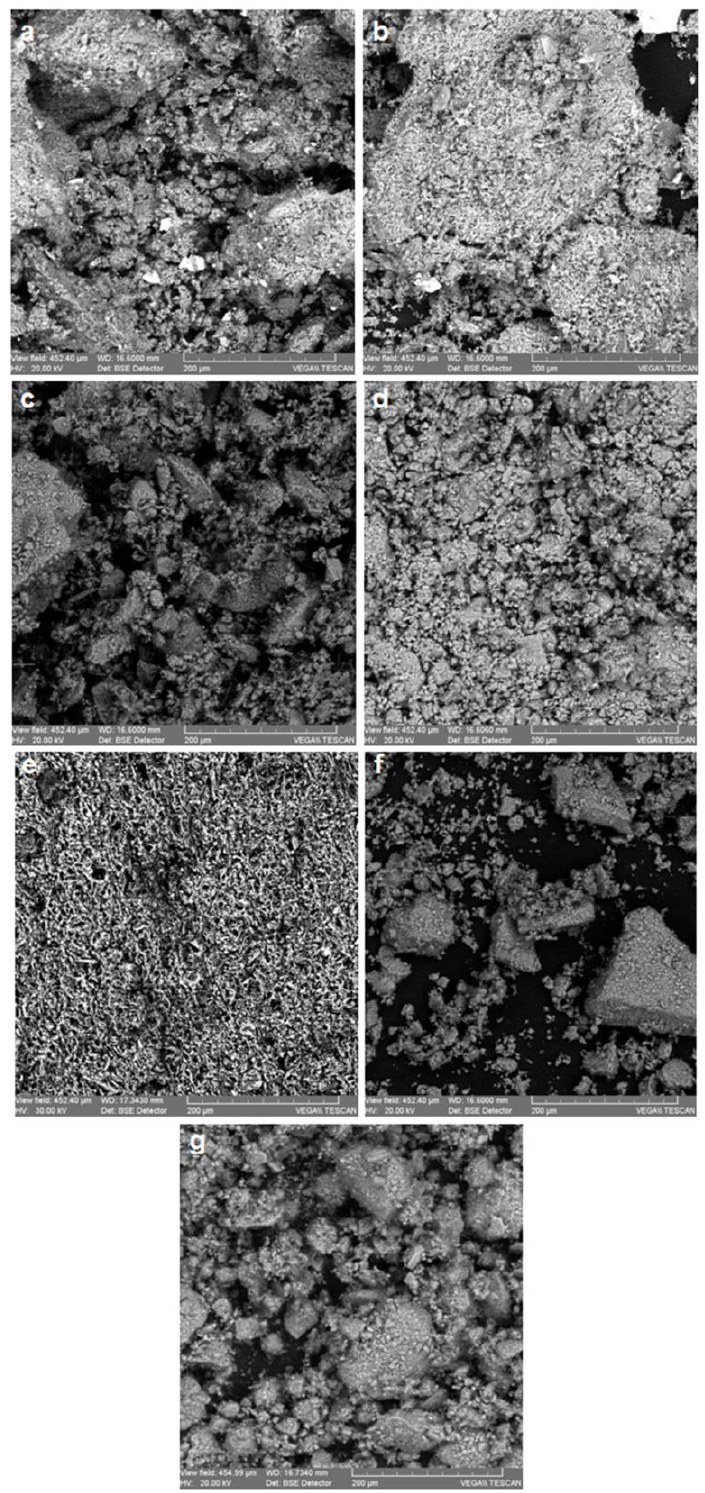
Figure 2. Scanning electron microscope images of the traditional ceramic samples (CT): ( a ) CT a acidic ceramic; ( b ) CT sa weakly-acidic ceramic; ( c ) CT amsa amphoteric low-acidic ceramic; ( d ) CT amsb amphoteric low-alkaline ceramic, ( e ) CT am amphoteric ceramic, f ) CT amHCl amphoteric ceramic treated with HCl 3M, ( g ) CT amsbHCl amphoteric low-alkaline ceramic treated with HCl 3M. The SEM analyzes allow, on the basis of the microphotographs from figures 1 and 2, assessing the structure and morphology of the sintering granules of the ceramic material.